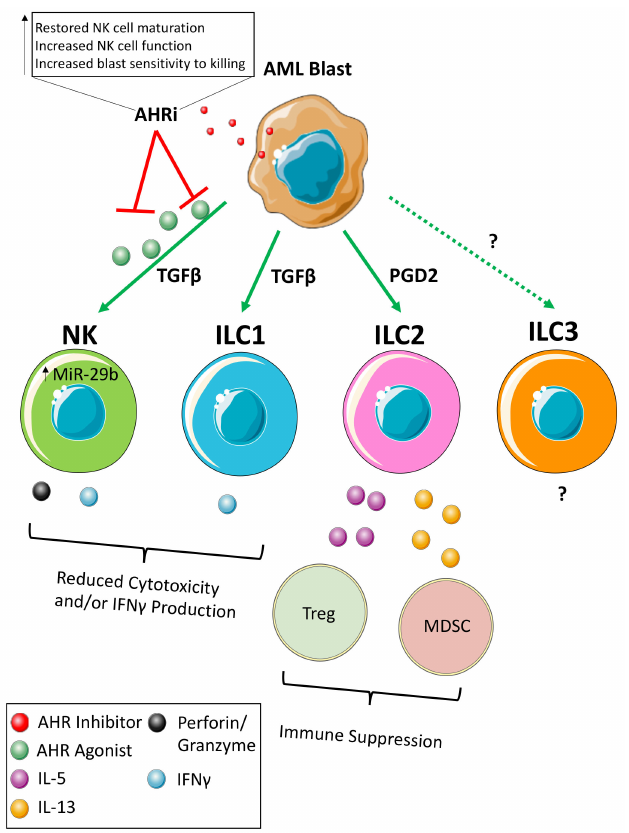
Figure 1. Schematic of ILC Dysregulation in AML. Working model of how AML blasts alter the function of innate lymphoid cell